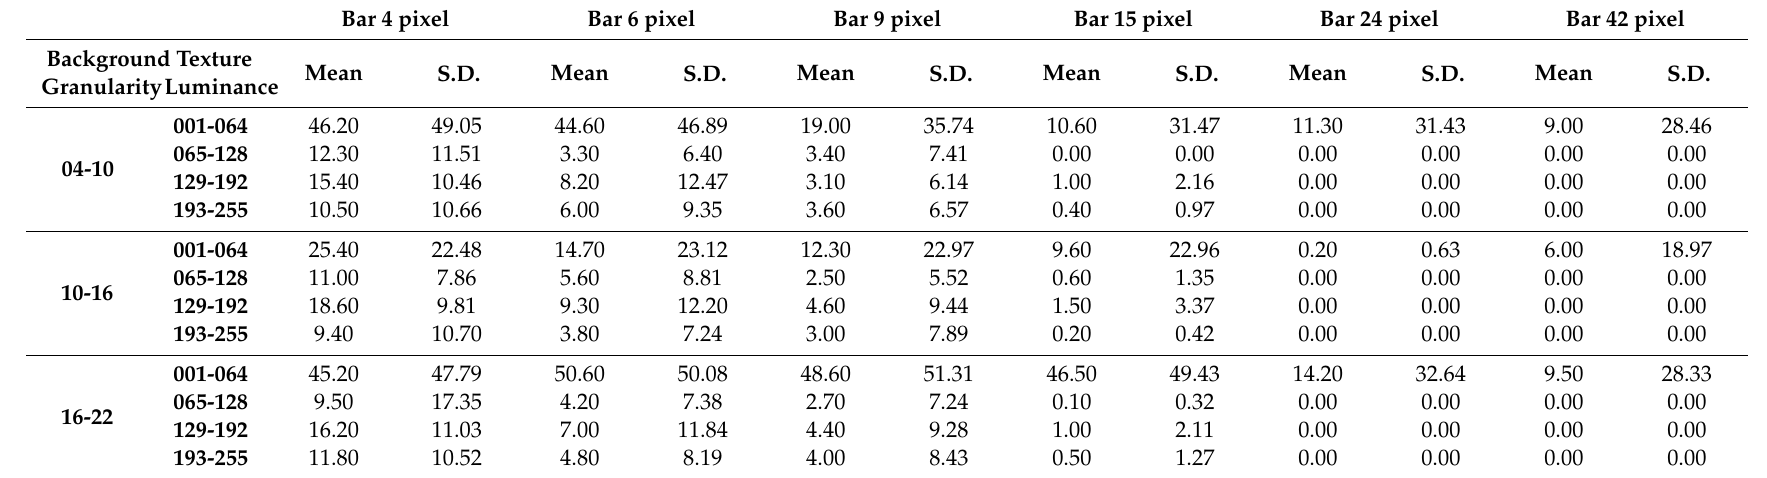
Table 7. Results of the third group of tests: textured Bar on textured Background—Background Texture manipulation (Granularity and